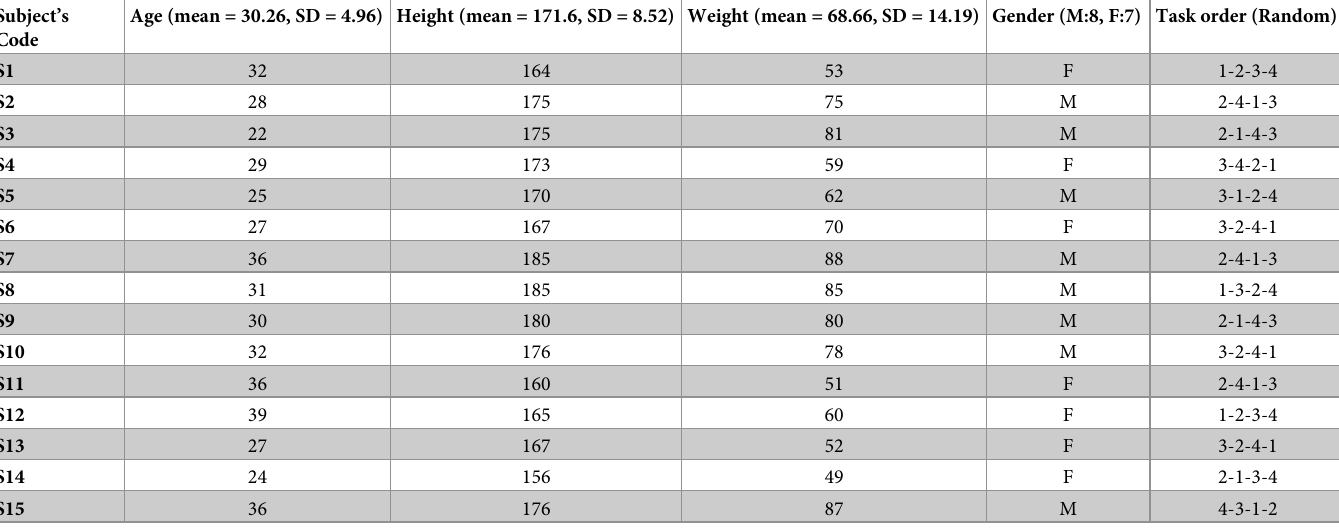
Table 1. Demographics and order of tasks for the subjects enrolled in the